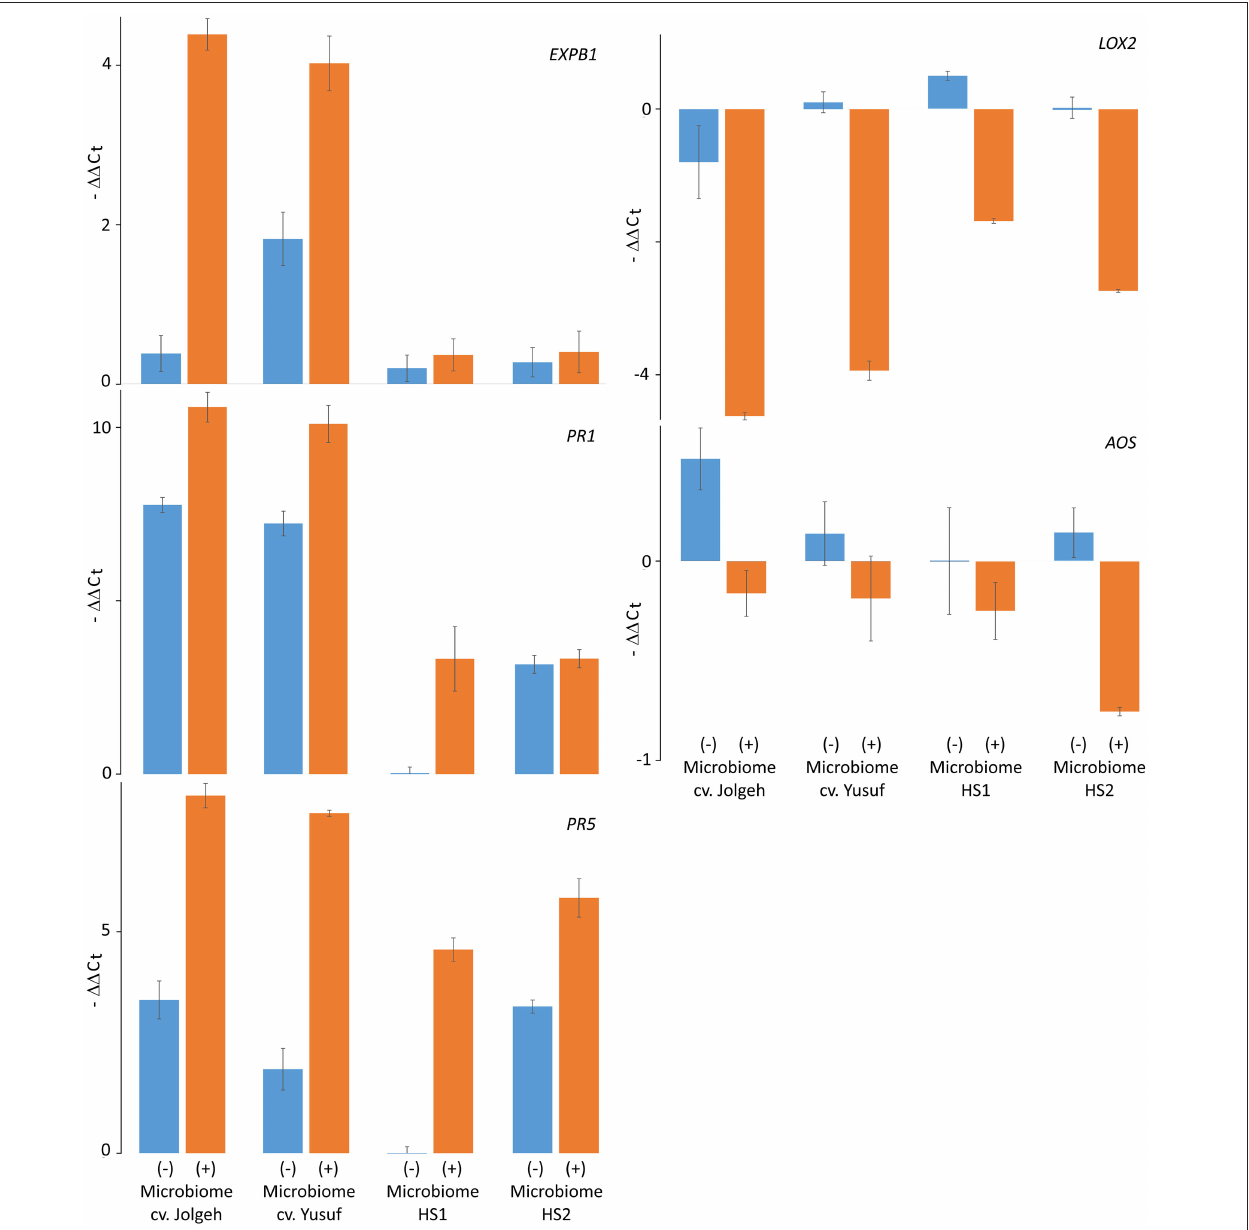
FIGURE 7 | Microbiome effect on defense gene response to RLN ( P. neglectus ) infestation in roots of elite cultivars (Jolgeh and Yusuf) and ancestral genotypes (HS1 and HS2) of barley. RNA was extracted, reverse-transcribed, and quantified in real-time PCR. The expression of genes EXPB1 , PR1 , PR5 , LOX2 , and AOS 5 days after inoculation of RLN was determined relative to expression in noninfected roots and normalized to gene expression of the control gene UBQ according to the – 11 C t method. Error bars represent SE ( n =